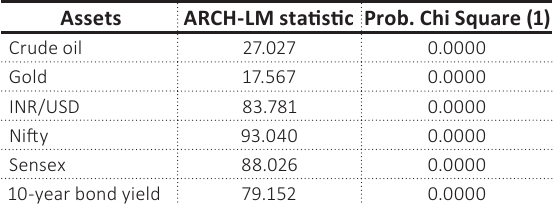
Table 4. ARCH-LM test result